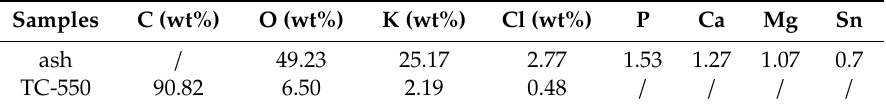
Table 1. The content of elements of tobacco stalk ash and TC-550